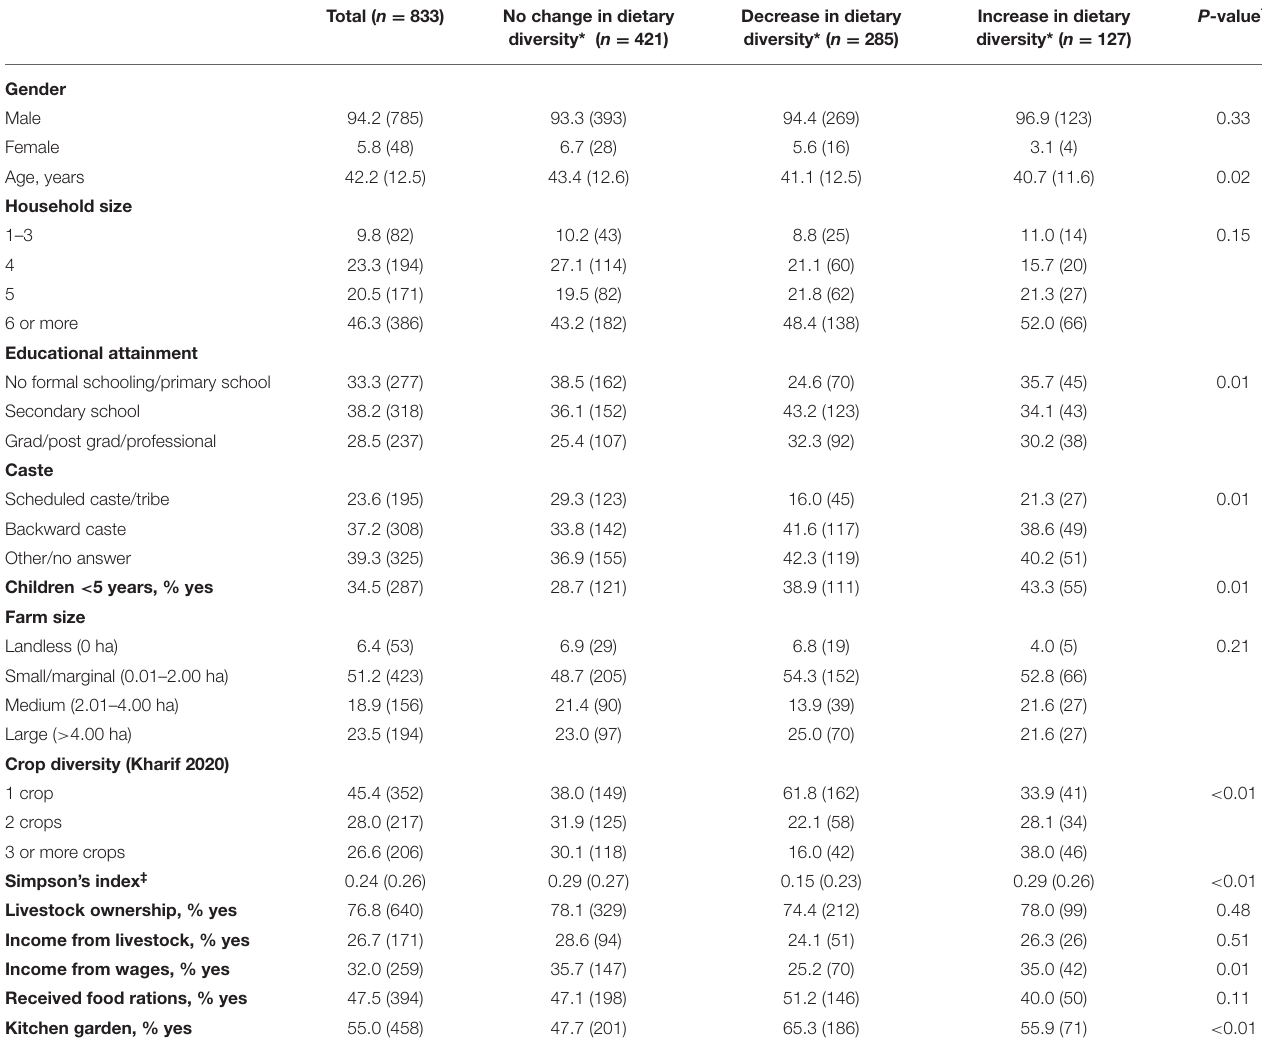
TABLE 1 | Demographic characteristics of participants from agricultural households across 12 states in India during the COVID-19 pandemic, according to change in dietary diversity from baseline (May 2020) to follow-up 1 (June 2020) ( n = 833). P -value Total ( n = 833) No change in dietary Decrease in dietary Increase in dietary diversity* ( n = 421) diversity* ( n = 285) diversity* ( n = 127)